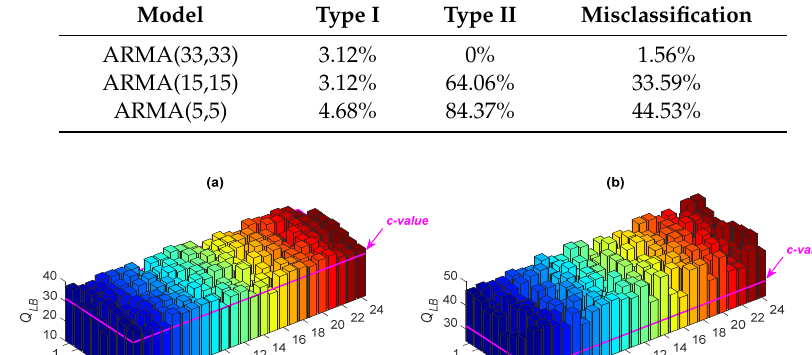
Table 3. Statistics of Type I and Type II errors, and misclassification rates by the PKLD-NN method, at varying orders p = q of the ARMA model.